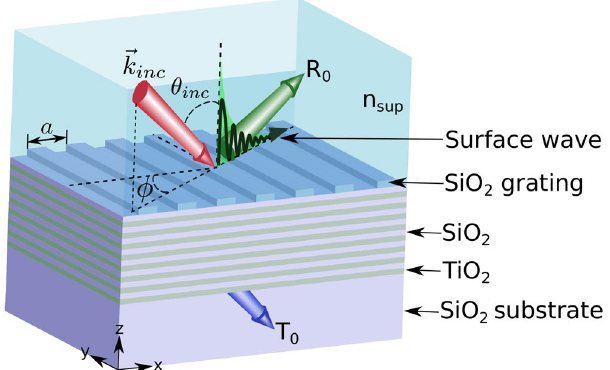
Figure 1. Schematic of a grating coupling technique to excite leaky Bloch surface waves on the surface of a dielectric